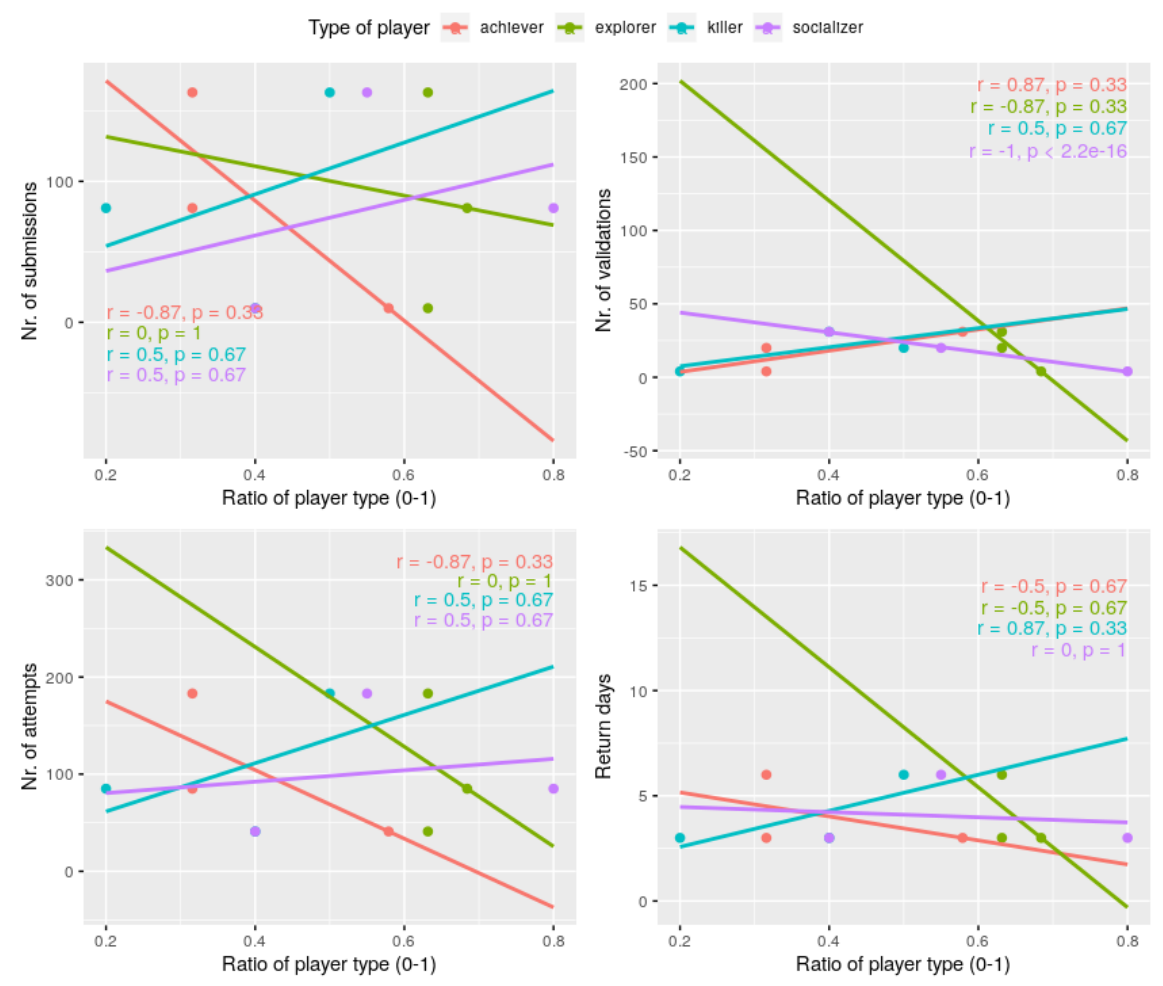
Figure 6. Spearman’s correlation between the different player types and the number of submissions, number of validations, total attempts, and return